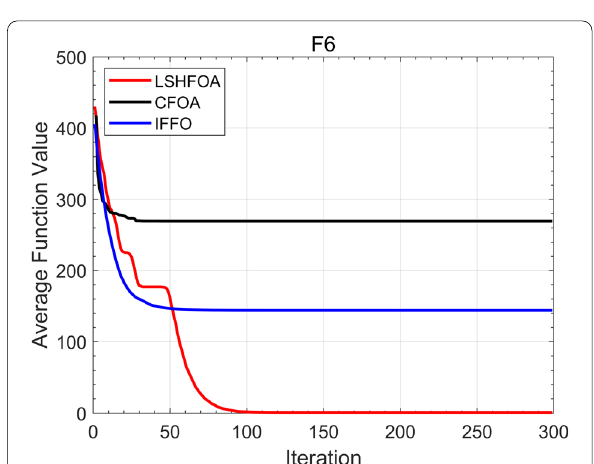
Fig. 12 Performance of the algorithm under F6